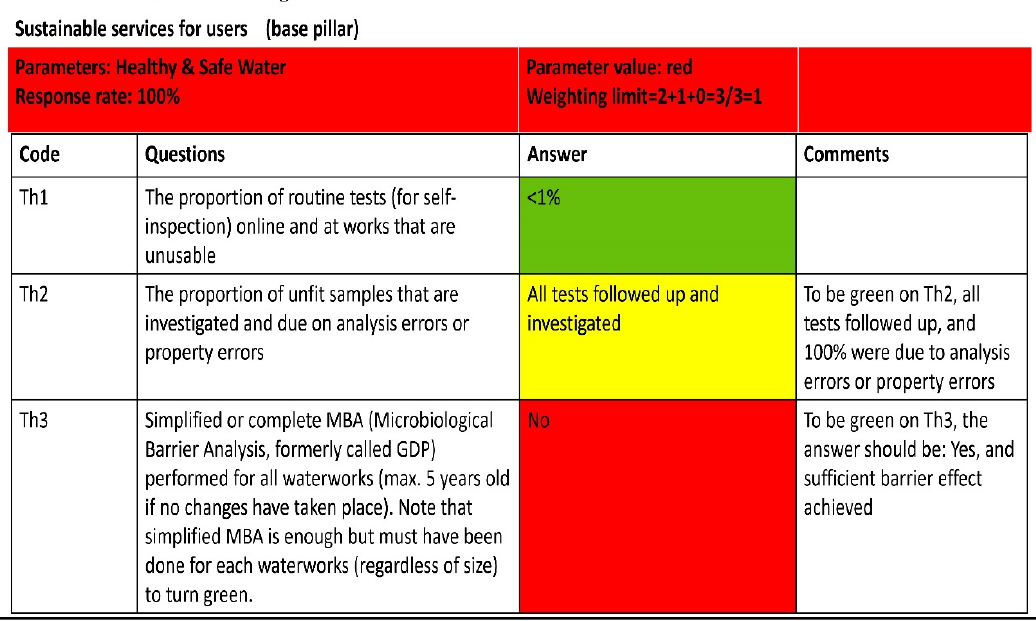
Figure 7. Part of SI evaluation details for Org 1 in 2019.